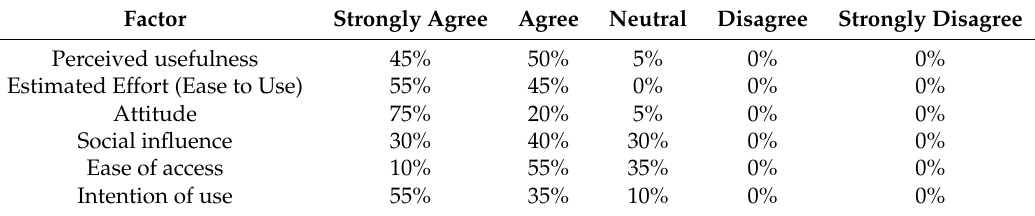
Table 3. Results of the